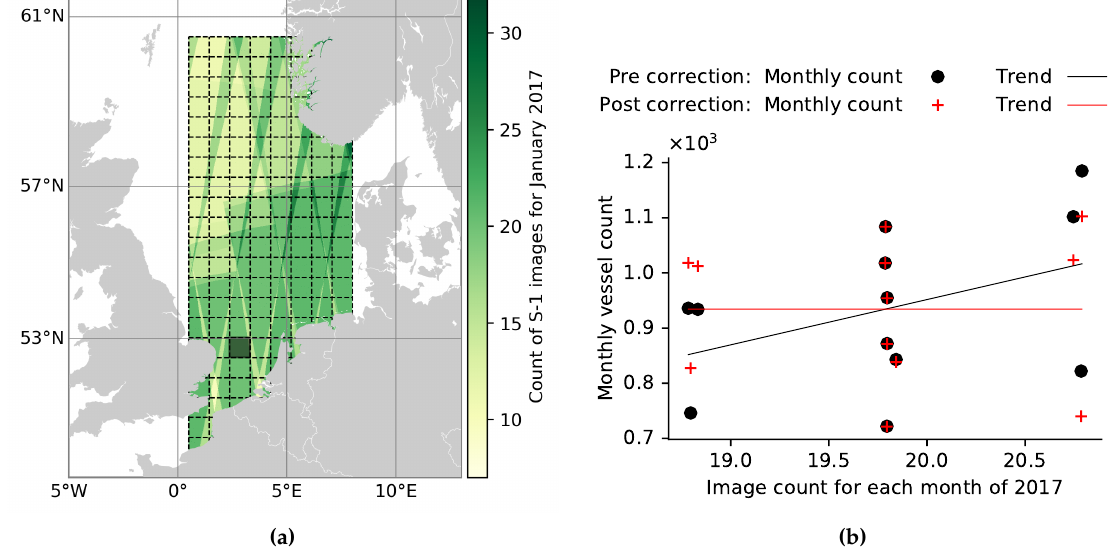
Figure 7. ( a ) The linear trend between monthly vessel count and monthly Sentinel-1 image count is computed for each cell of the grid (dashed lines). The correction for the shaded cell is shown in ( b ), it consists in removing the positive linear trend between monthly vessel count and monthly S-1 image count.